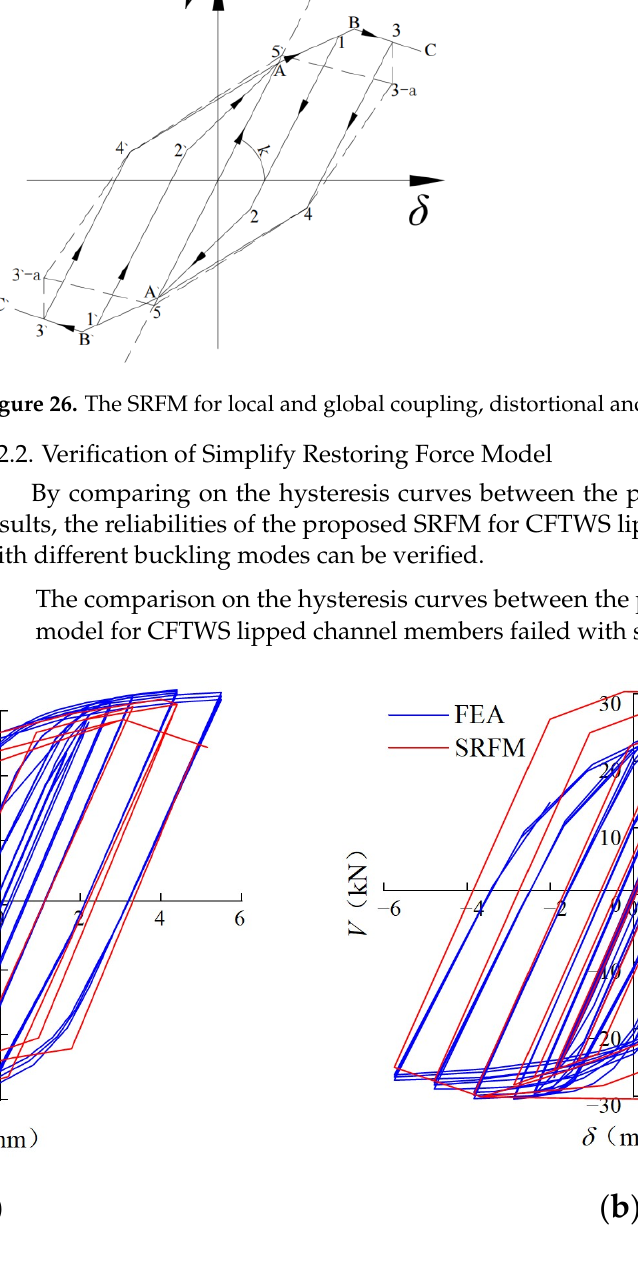
pling, distortional and global coupling destruction predominate is shown in .